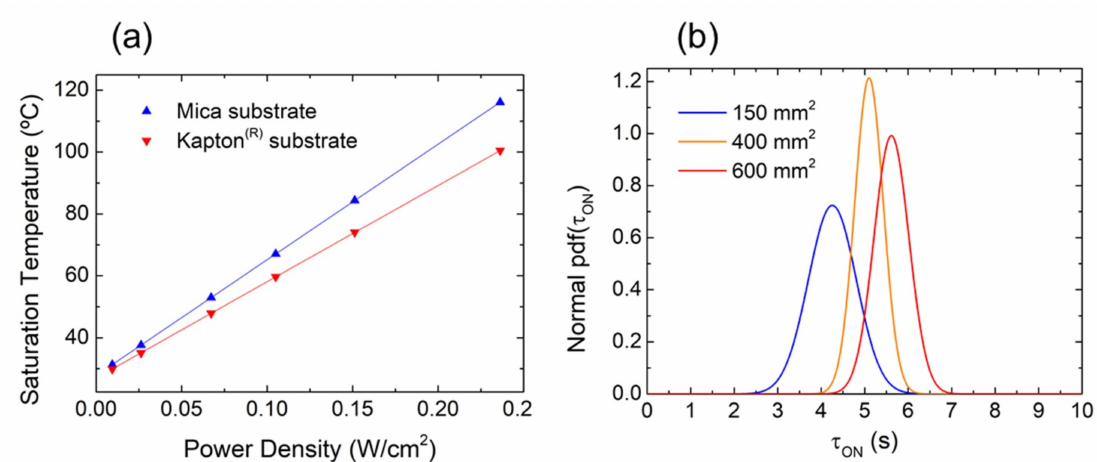
Figure 4. ( a ) Saturation temperature as a function of the input power density for two equal 400 mm 2 LrGO heaters on two di ff erent substrates. ( b ) Probability density function of the response time for di ff erent heaters on Kapton ®